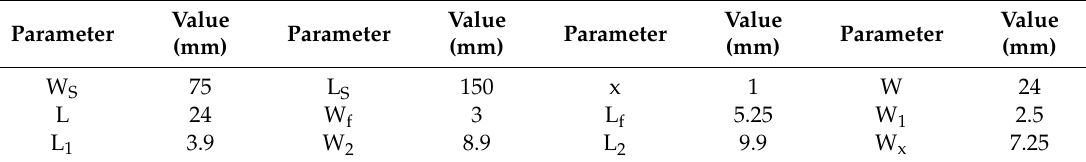
Figure 1. The antenna schematic, ( a ) side view, ( b ) top and ( c ) bottom layers. Table 1. Parameter values of the single-element antenna and its MIMO array